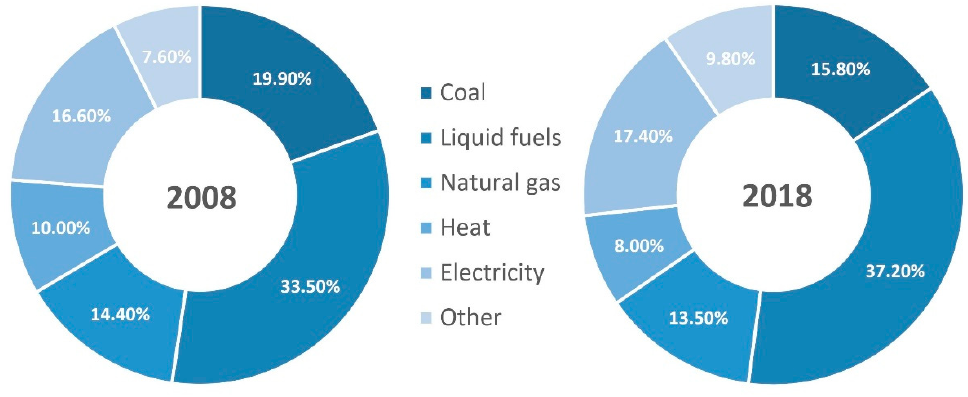
Figure 4. StructureoffinalenergyconsumptioninPolandbycarrier,2008and2018. Source: Peryt et al. Figure 4. Structure of final energy consumption in Poland by carrier, 2008 and 2018. Source: Peryt et al. [115].